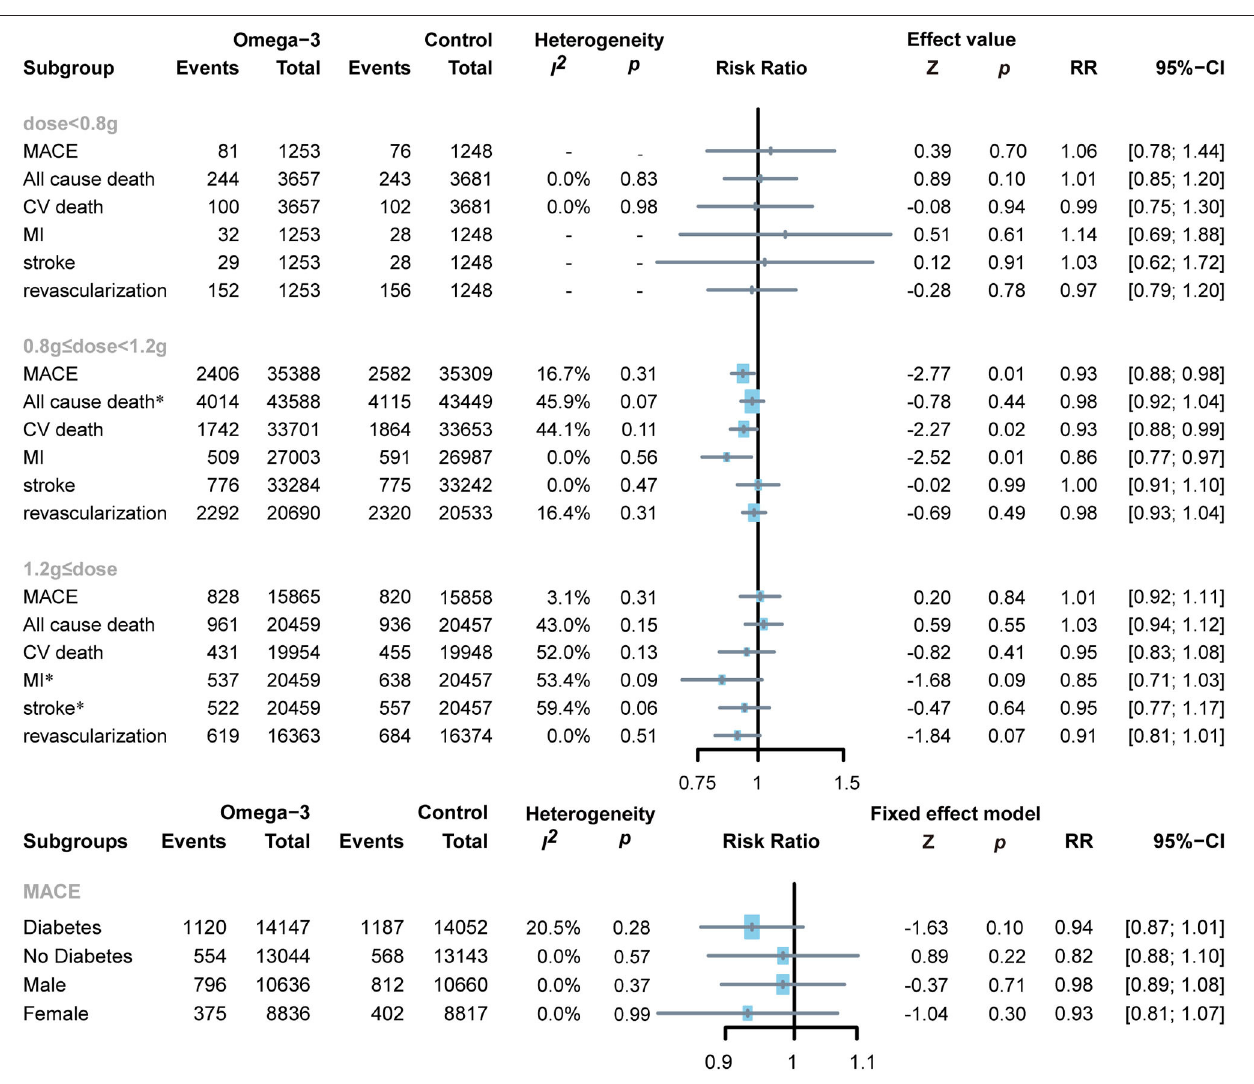
FIGURE 6 | Forest plot of subgroup of the application dose of omega-3 FA, diabetes or not, and sex. MACEs, major adverse cardiovascular events; CV death, cardiovascular death; MI, myocardial infarction. *Random-effects